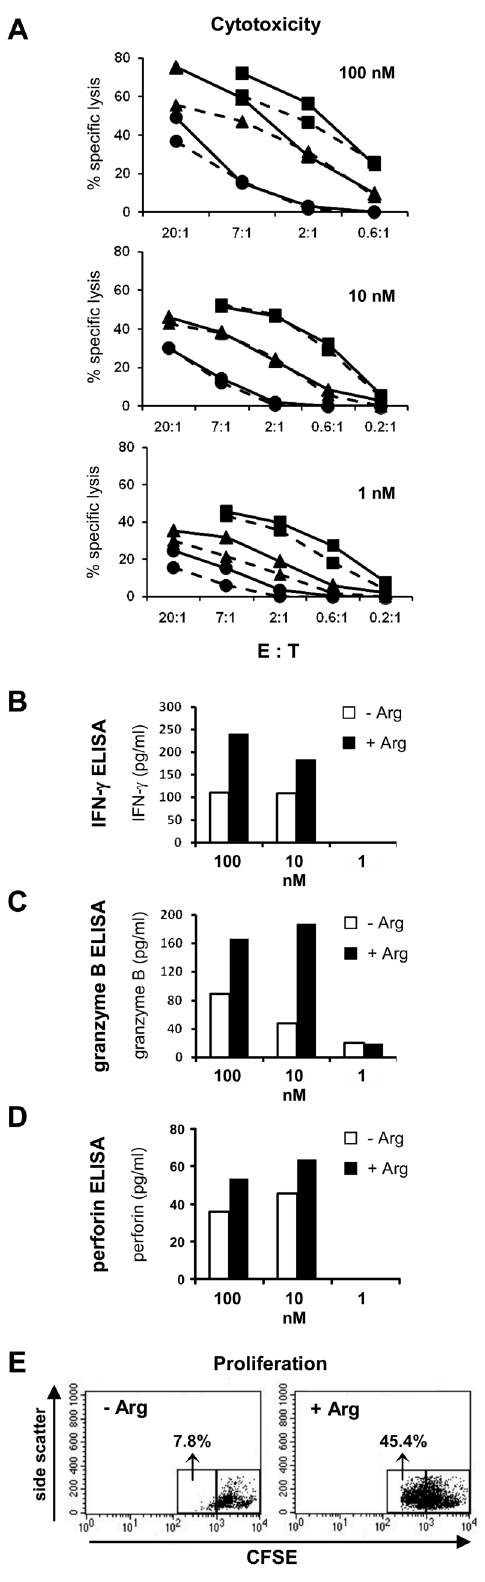
Figure 6. Impact of arginine depletion on cytotoxic capacity, cytokine secretion and proliferation of human CD8 + CMV antigen specific T cells expanded from the natural repertoire. Expanded CMV pp65 aa495–503 specific T cells of 2 HD (